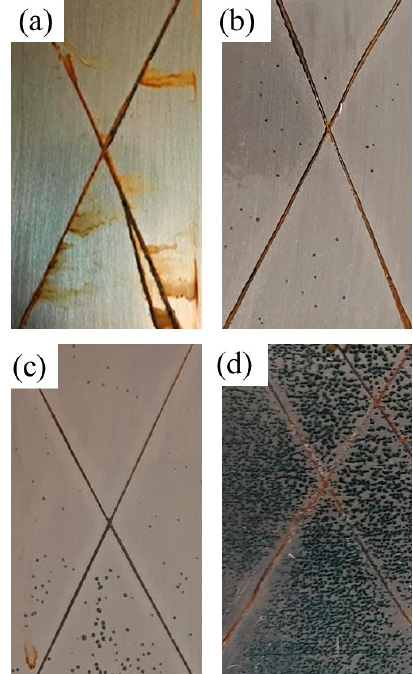
Figure 7. Images of the scratched coatings after salt spray test: ( a ) Sample A; ( b ) Sample B; ( c ) Sample C; ( d ) Sample D.